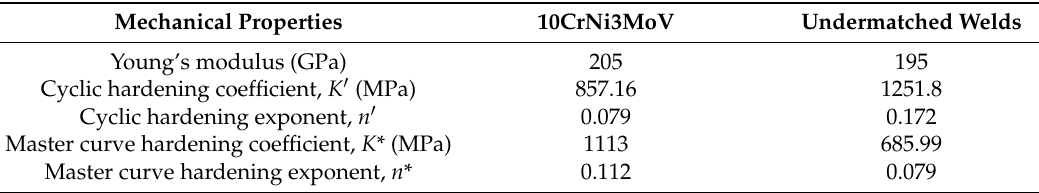
Figure 7. Stress-strain comparison between monotonic tension and cycle Ramberg-Osgood relationships: ( a ) 10CrNi3MoV steel; ( b ) Undermatched welds. Table 5. Mechanical properties of test